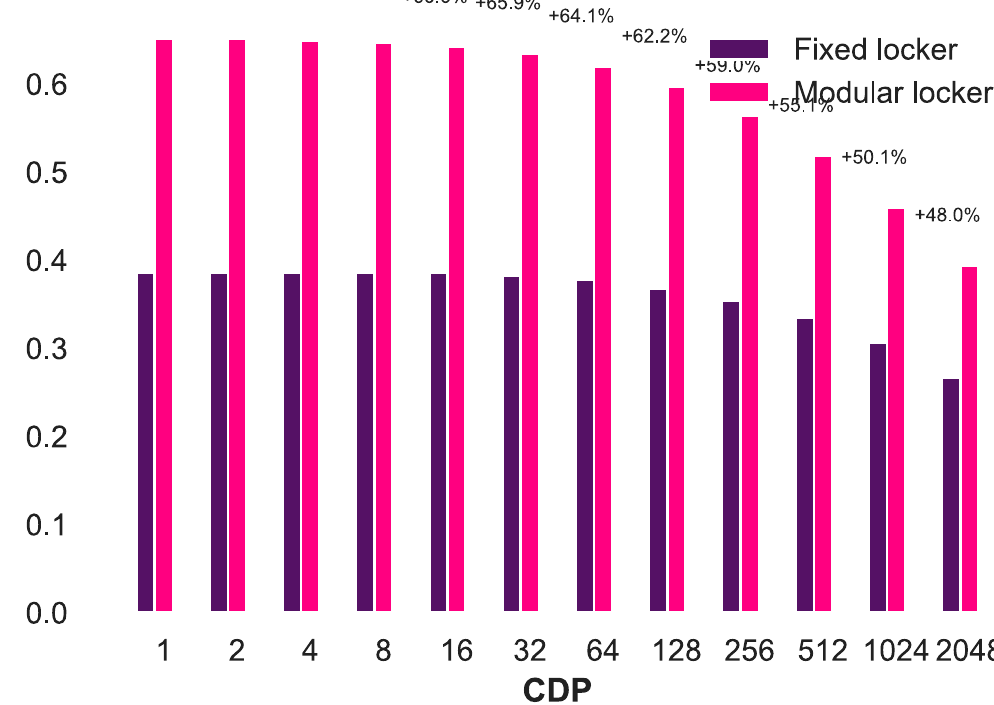
Figure 11. Comparison of the average utilization of fixed lockers with modular lockers, which are adjusted in the beginning of each month.